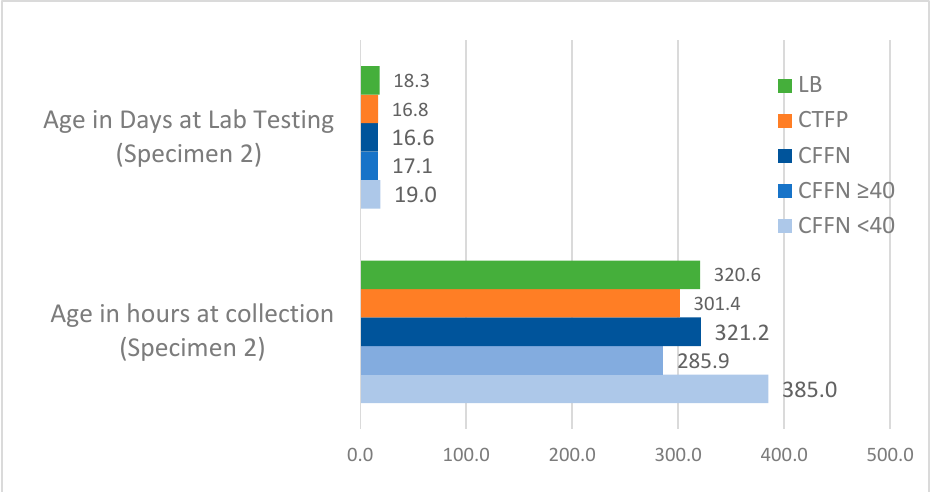
Figure 5. Weighted average median age at specimen collection and laboratory testing for all study groups in 3 two-specimen states: Specimen 1. (Median ages for CFFNs with IRT ≥ 40 ng/mL based on 2 states).